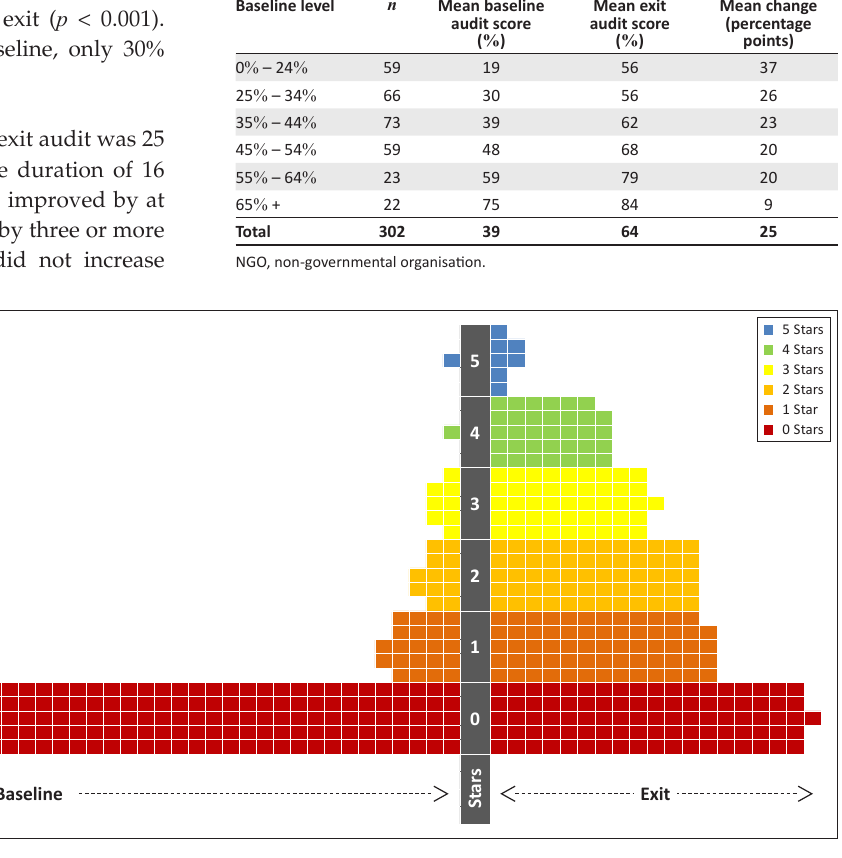
TABLE 2: Improvement by baseline level based on the Stepwise Laboratory Quality Improvement Process Towards Accreditation checklist. Baseline level